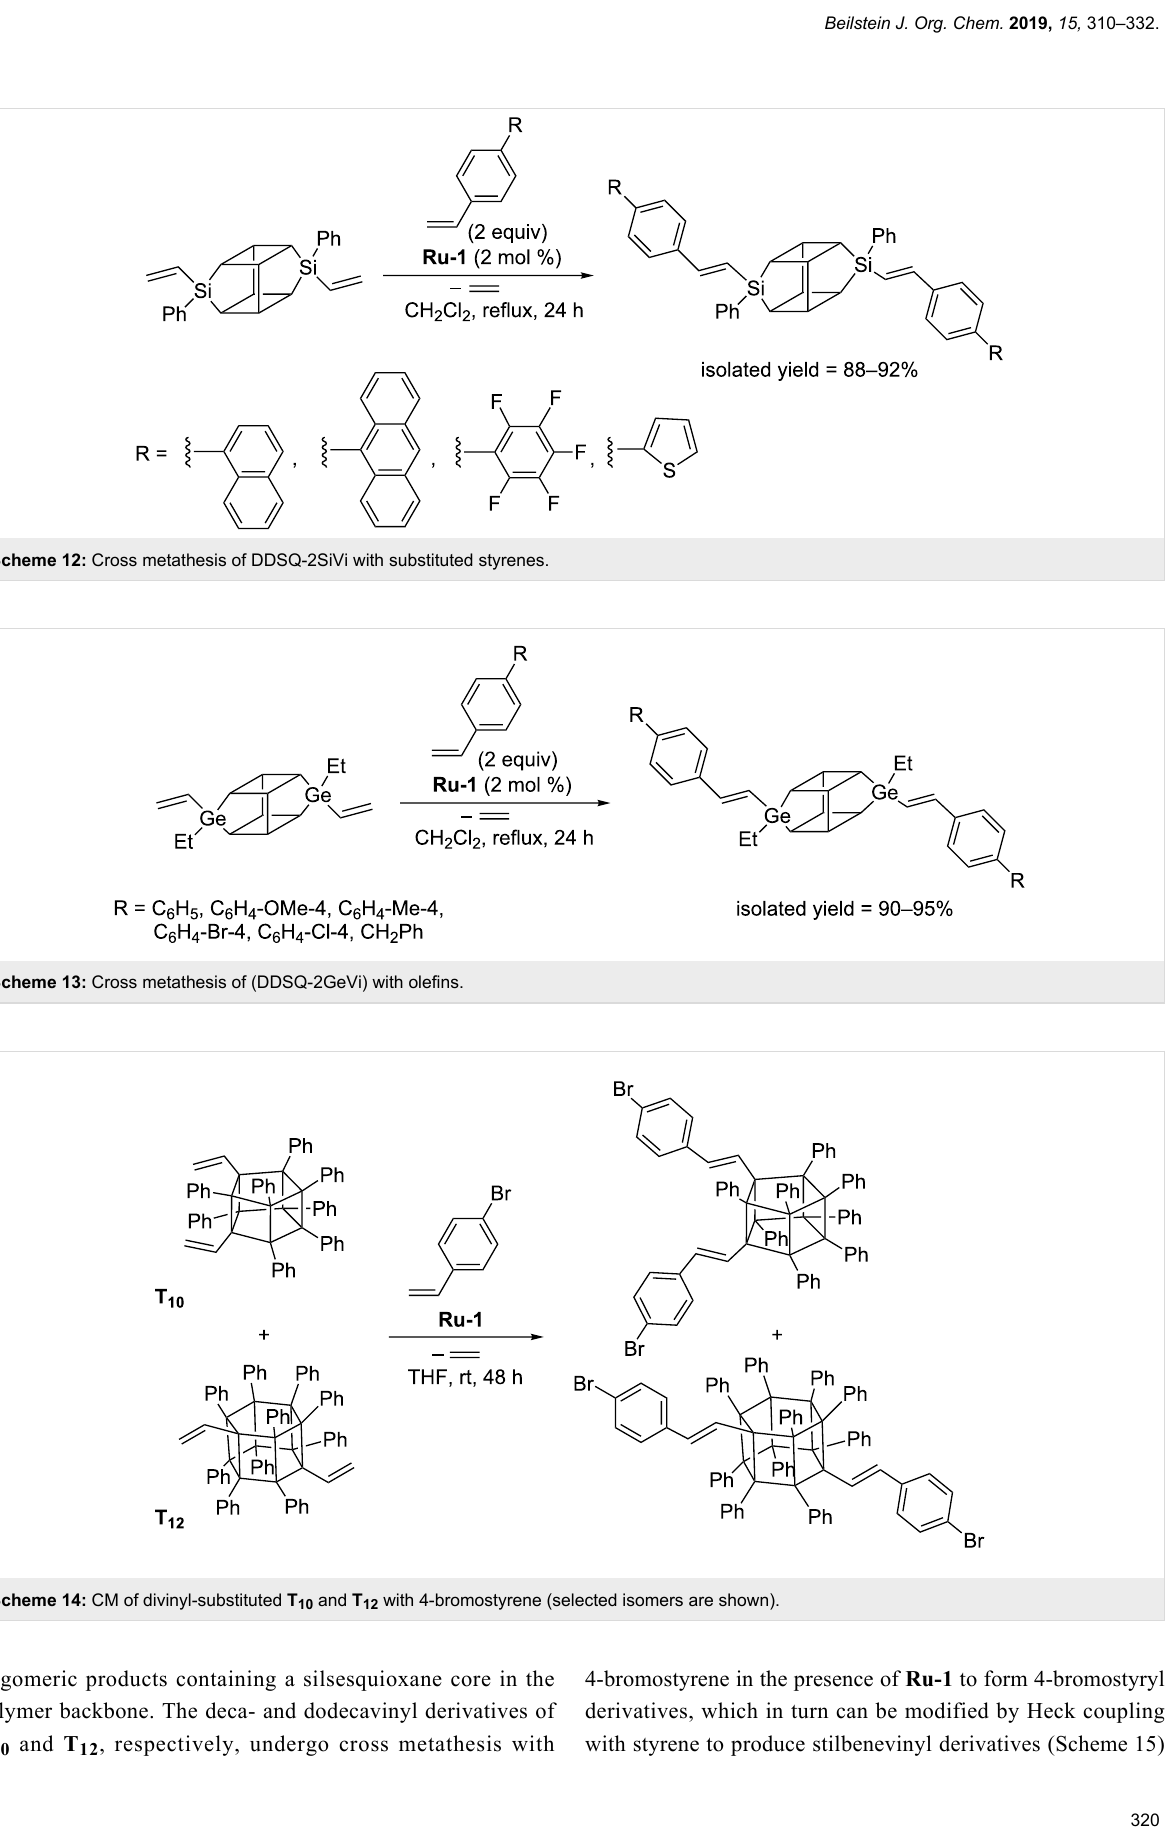
oligomeric products containing a silsesquioxane core in the polymer backbone. The deca- and dodecavinyl derivatives